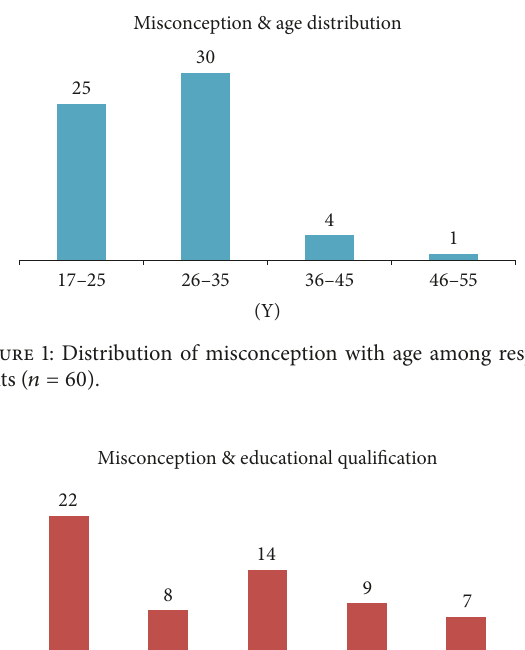
Table3:Distributionofcomorbiddisordersamongtherespondents